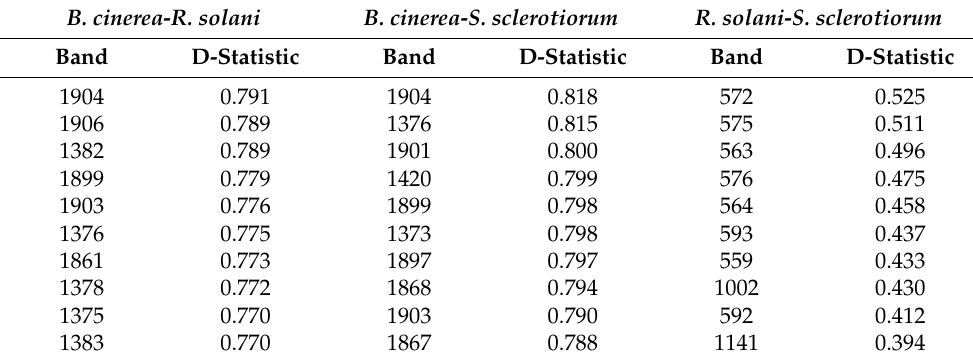
Table 1. The 10 wavelengths most useful for distinguishing the three fungi species based on the values D-statistic.